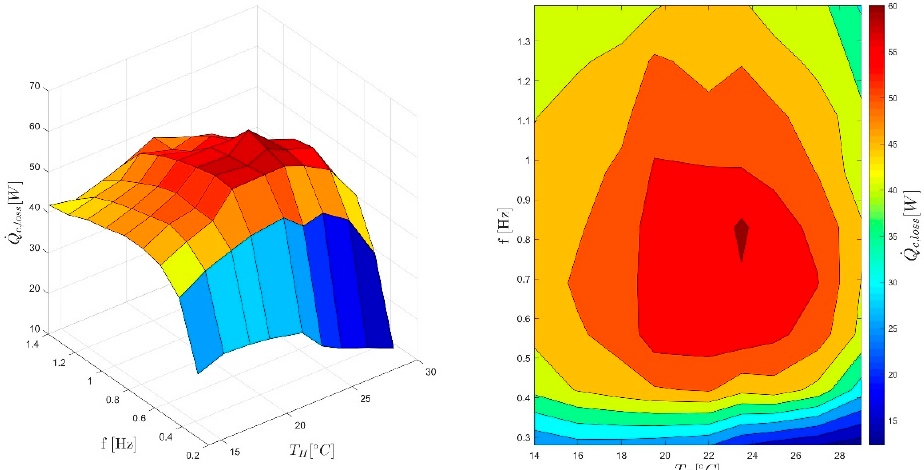
Figure 14. Parasitic thermal load of the rotary valve simulated by the thermal model with di ff erent operating frequencies and hot source temperatures.